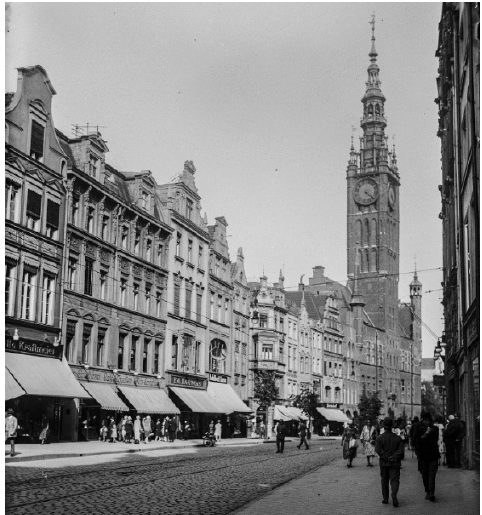
Figure 6. D ł uga Street in Gda ń sk, 1935. Source: Historical Museum of the City of Gda ń sk . Figure 6. Długa Street in Gda´nsk, 1935. Source: Historical Museum of the City of